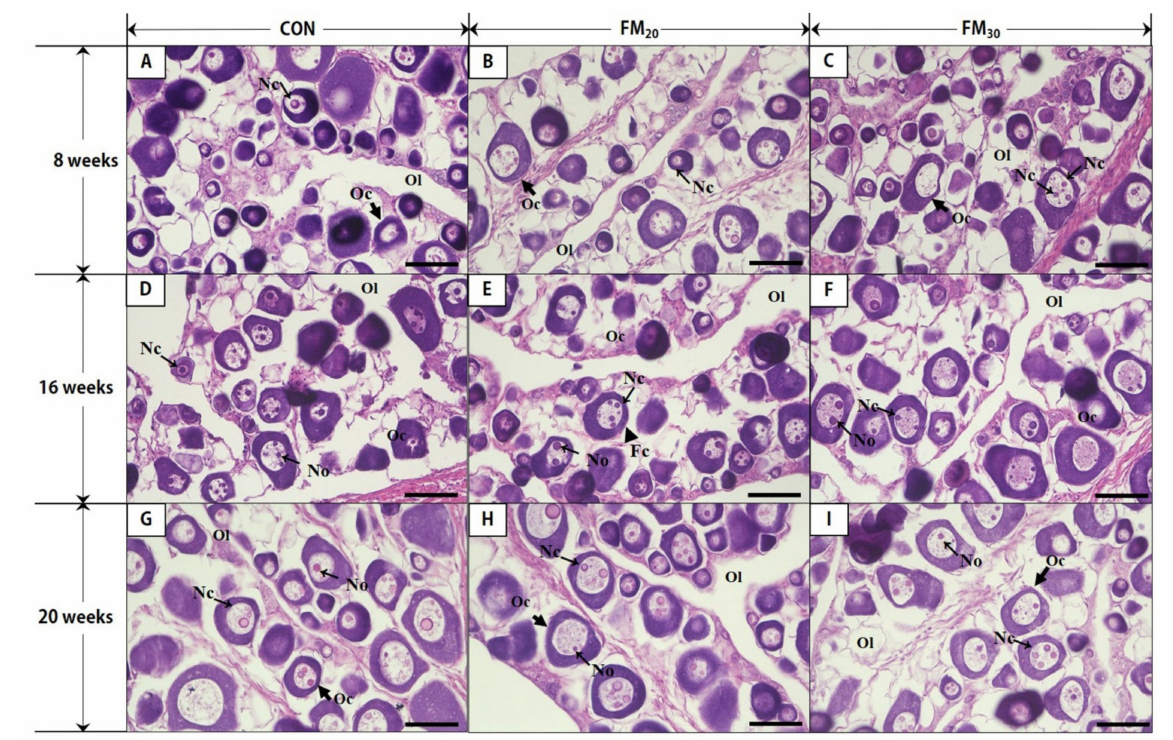
Figure 3. Hematoxylin and eosin-stained gonads of female olive flounders ( Paralichthys olivaceus ) fed low-fishmeal diets. ( A – C ), oocytes of 8 weeks ( n = A − 18, B − 16, C − 15); ( D – F ), oocytes of 16 weeks ( n = D − 15, D − 17, E − 10); ( G – I ), oocytes of 20 weeks ( n = G − 14, H − 18, I − 17). CON, control diet; FM 20 , diet with 20% of the fishmeal replaced; FM 30 , diet with 30% of the fishmeal replaced. Oc, oocyte; Nc, nucleus; No, nucleolus; Fc, follicular cell; Ol, ovarian lumen. Scale bars = 50 µ m.